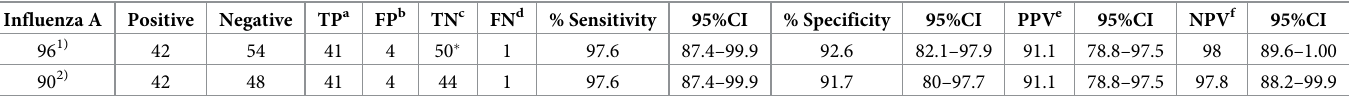
Table 4. Sensitivity and specificity of Linjudge